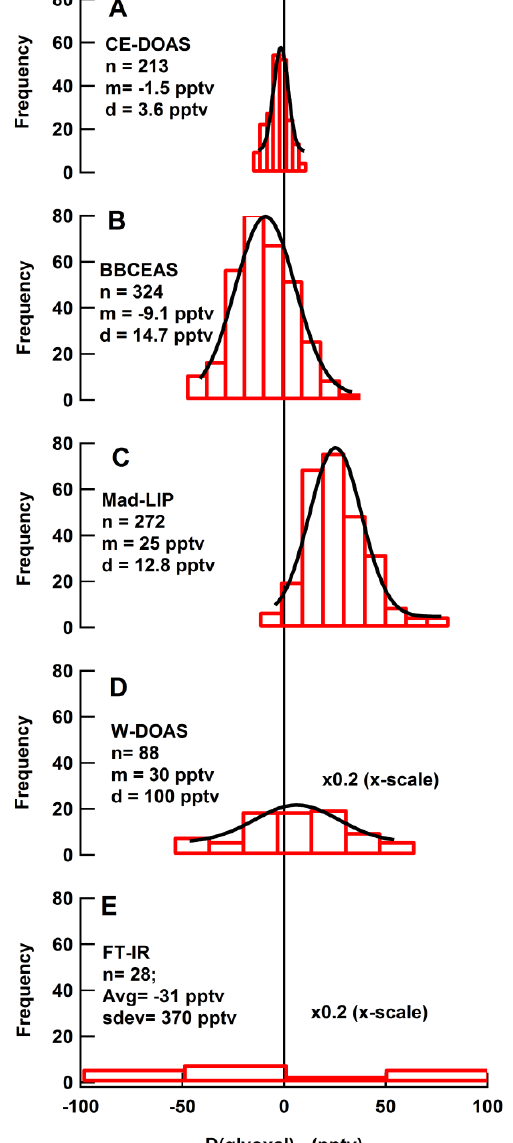
Figure 9. Histograms of glyoxal baseline variability during exper- iment E8b, 6 July 2011 from 02:00–06:00UTC. The instruments sampled from a clean chamber. The number of points in the distri- bution ( n ), the mean ( m ) and 1- σ standard deviation ( d ) are listed on each graph, and experimentally determined limits of detection as quoted in Table 4 were calculated as LOD exp = 3 × d +| m | . The time series of the data used to produce the histograms is shown in Fig. S8b and c.